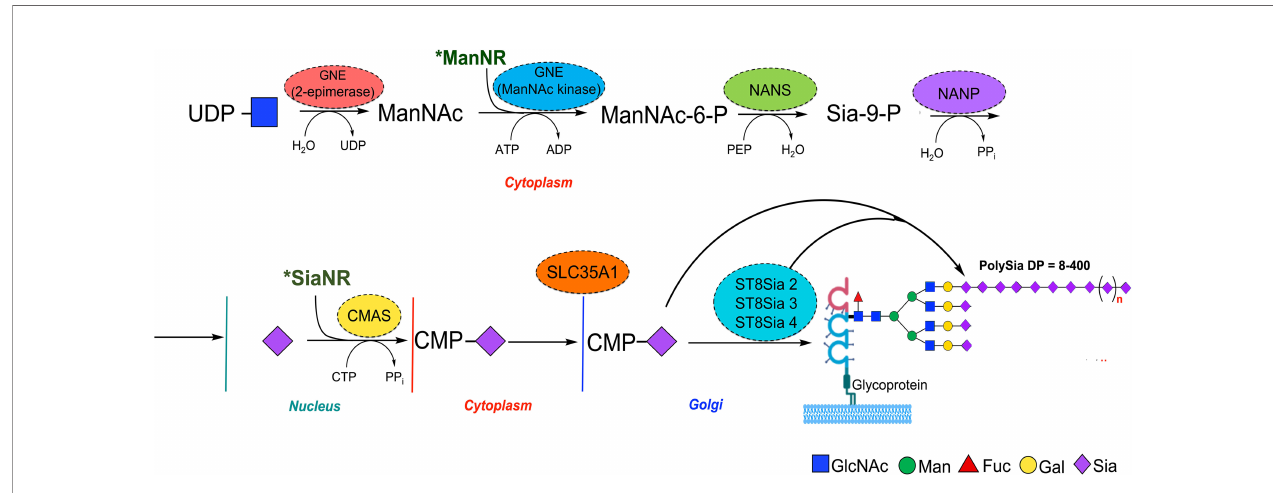
FIGURE 1 | Schematic representation of mammalian polySia biosynthesis. Biosynthesis of PolySia is based on the building block of monomers of Sia through conversion of UDP-GlcNAc into ManNAc by the GNE bifunctional enzyme (epimerase) and subsequently to ManNAc-6-phosphate (kinase). The ManNAc-6- phosphate is then transformed into Sia-9-P by the N-acetylneuraminate synthase (NANS) and dephosphorylated by Sia-9-P-phosphatase (NANP) to yield Sia. After that, Sia is transferred to the nucleus and conjugated with cytidine monophosphate (CMP) by the CMP-Sia synthase (CMAS) and translocated into the Golgi by the CMP-sialic acid transporter SLC35A1, where sialyltransferases, including ST8Sia 2, 3, and 4, use it as donor substrate for polySia synthesis. Synthetic derivatives of ManNAc (ManNR) and Sia (SiaNR) can be used to metabolically label Sia glycans, including